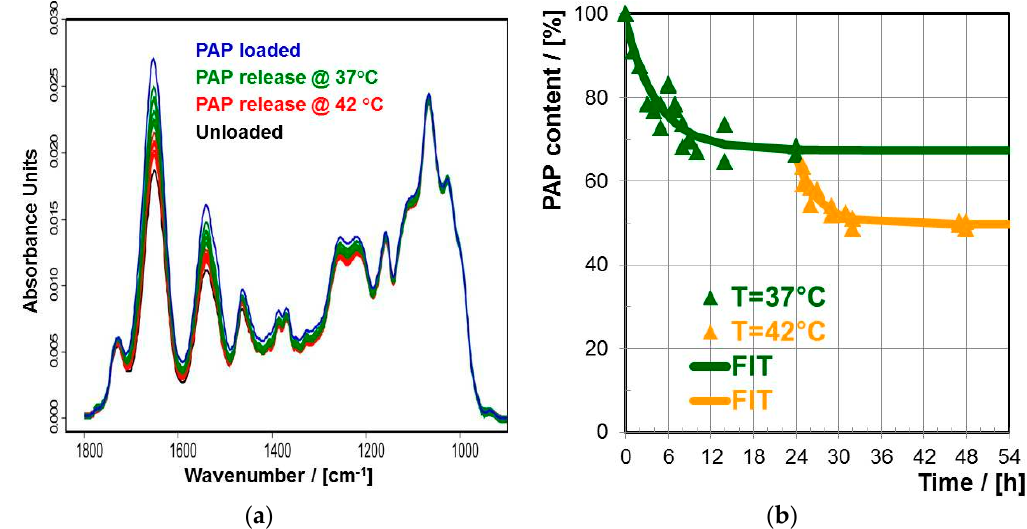
Figure 6. ( a ) Typical TRANS-FTIR spectra of PNIPAM-DMAEMA/CS-1.2 coatings before loading (black), after loading with PAP for 12h (blue) and after releasing PAP upon rinsing in HEPES buffer for 24 h at T = 37 °C (green), at T = 42 °C (red). ( b ) Release kinetics of papain (PAP) out of PAP loaded PNIPAM-DMAEMA/CS (PEC-1.2, 0.01 M) coatings at Ge for T = 37 and 42 °C into HEPES buffer based